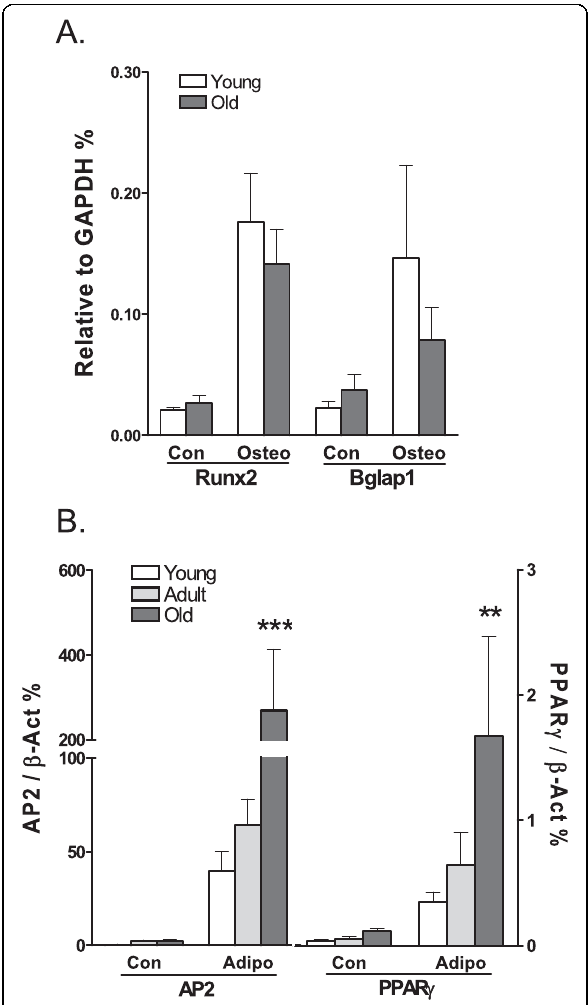
Figure 2 Expression of osteogenic and adipogenic marker genes in young and old ADSCs . A . Expression of Runx2 and Bglap1 relative to GAPDH in young and old ADSCs after osteogenic induction (Osteo) for 21 days. The marker expression in non- induced cells (Con) is shown. No significant difference was found between young and old ADSCs. N = 6. B . AP2 and PPAR g gexpression relative to b -actin expression in young, adult, and old ADSCs subjected to adipogenic induction (Adipo) for 14 days. The non-induced samples were induced for 21 days as in A. ***: P < 0.001, **: P < 0.01 (N = 3), compared ΔΔ CT to young or adult ADSCs.